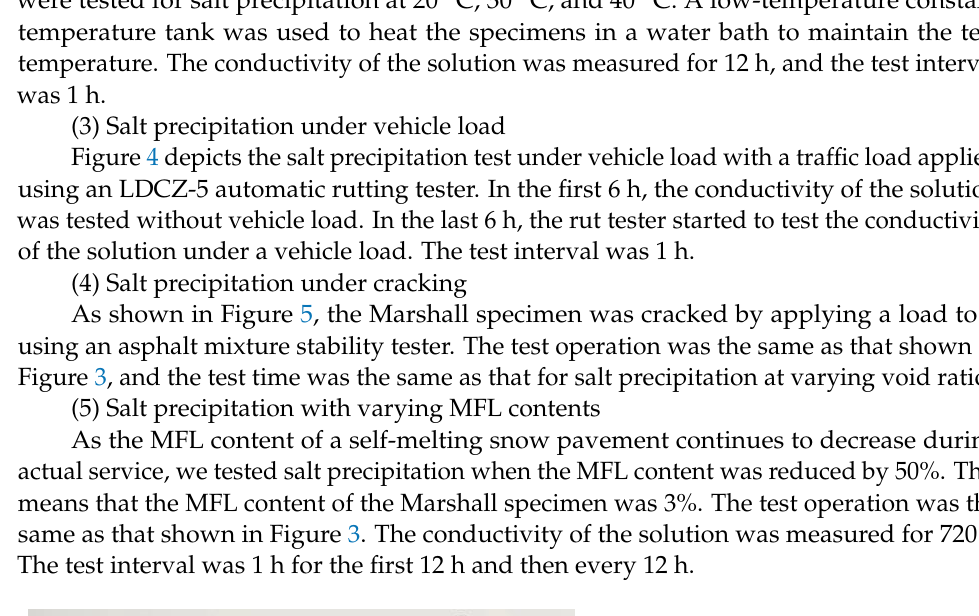
Figure 3. Diagram of salt precipitation test by full dissolution method: ( a ) 1500 mL drinking water; ( b ) DDS-11A conductivity meter; ( c ) Marshall specimen; ( d ) three stones.